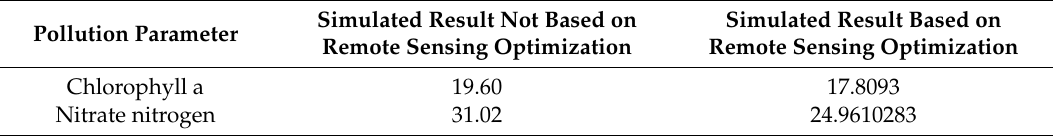
Table 6. Contrastive analysis of the verify point mean square error (MSE) (%).